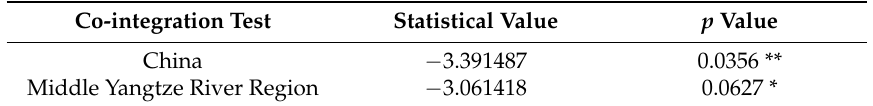
Table 3. Co-integration test results.